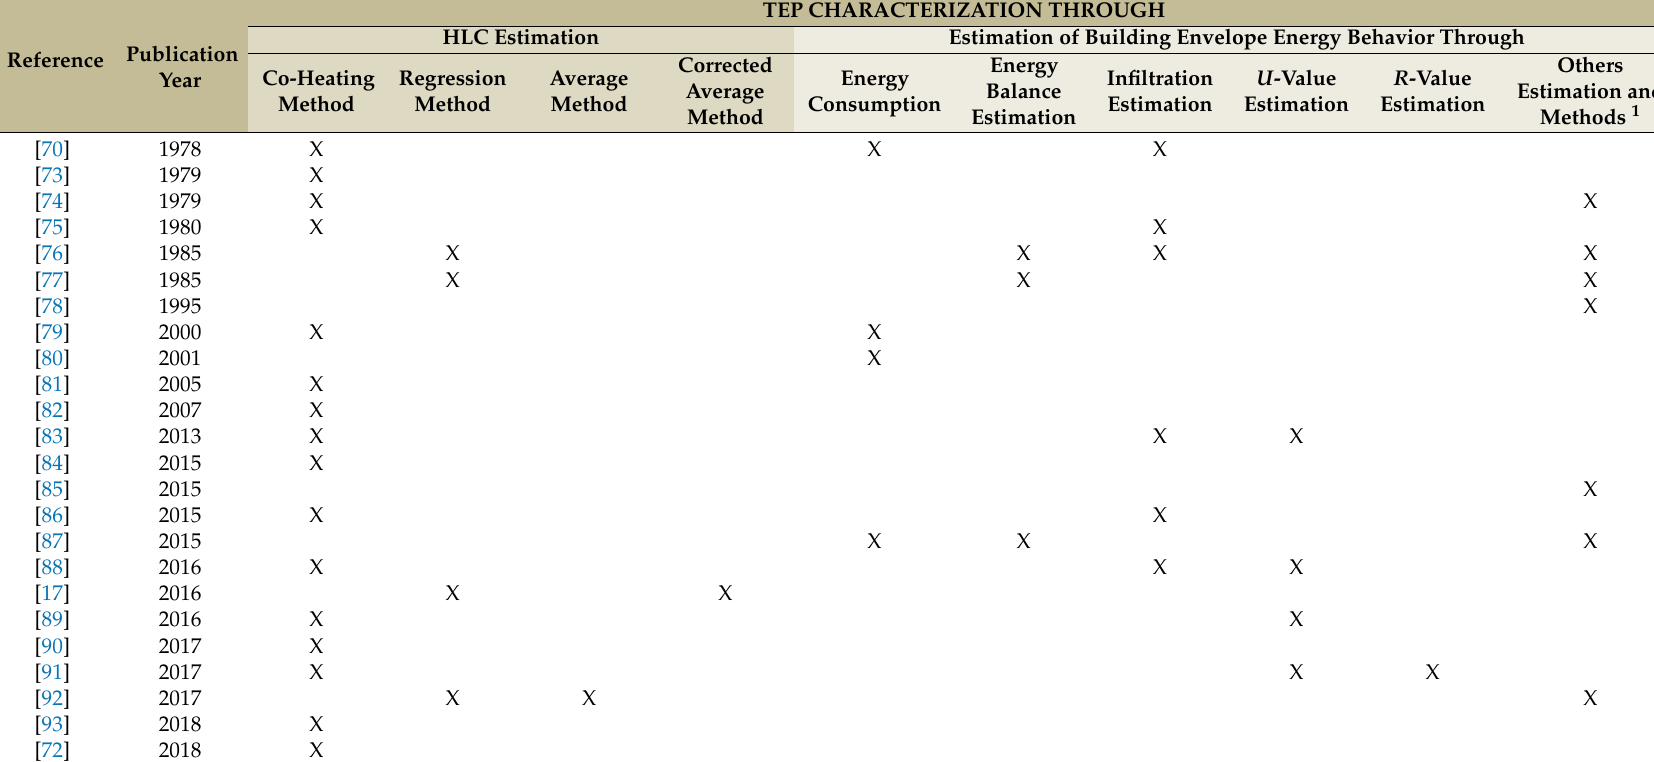
Table 8. List of publications used in the MCS to characterize the TEP of in-situ buildings through HLC estimation and other estimates used to determinate energy behavior of the